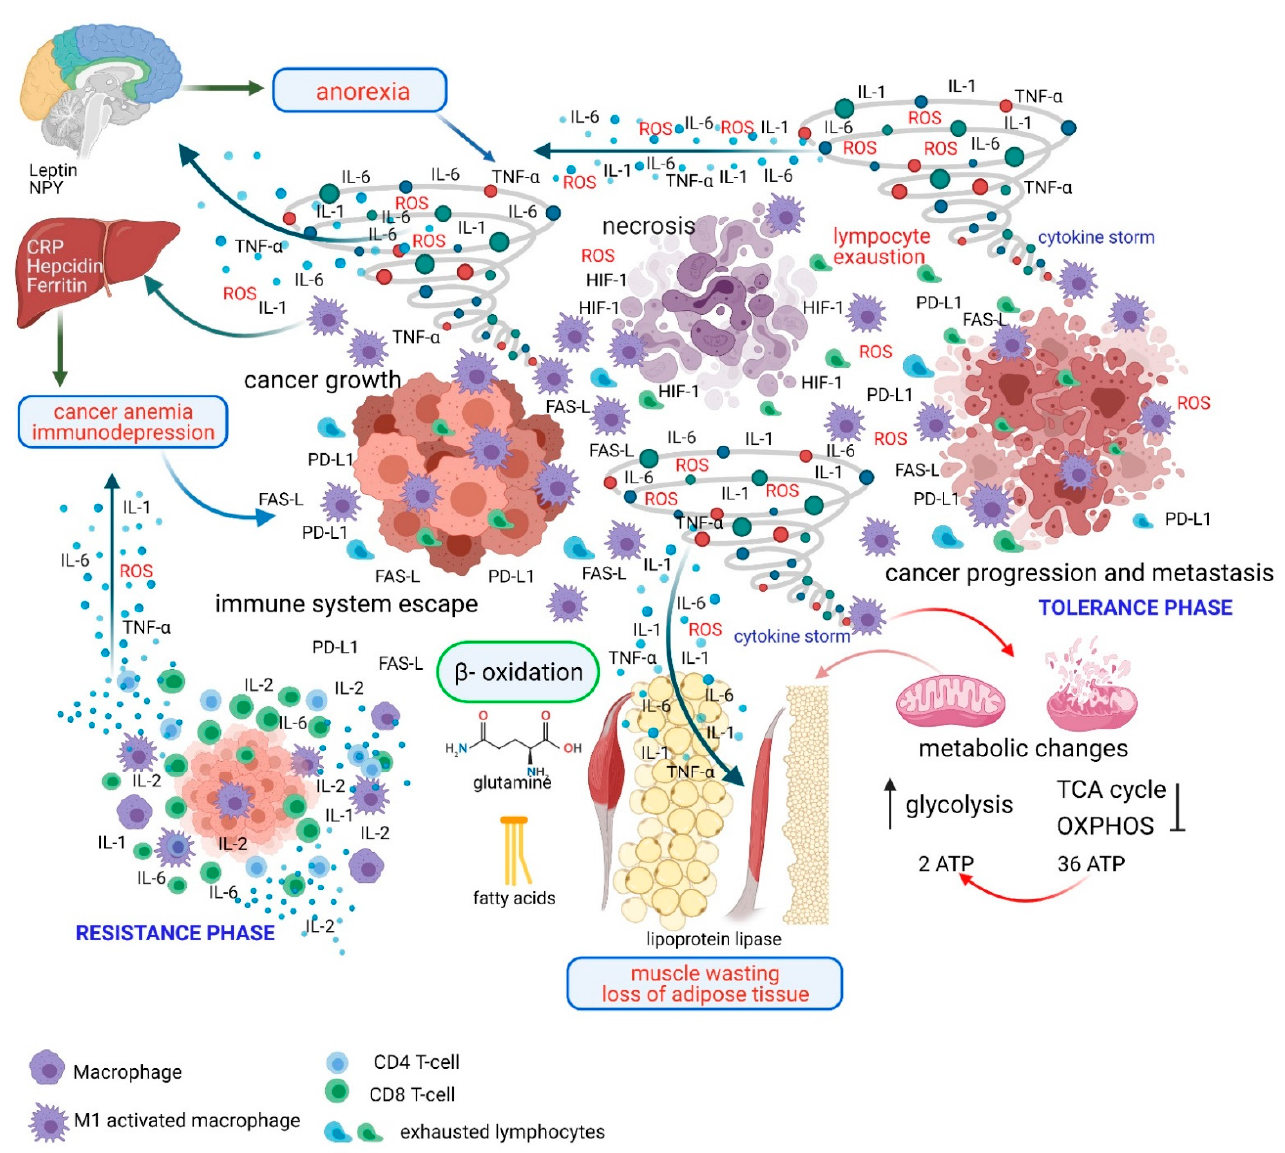
Figure 1. Mechanism of resistance and tolerance and pathogenesis of cachexia during the evolution of cancer. In the resistance phase the immune system recognize the antigenic diversity of the tumor and tries to eliminate it. Macrophages, dendritic cells and T and B cells are the main participants. In this phase the presence of cancer cells and the activation of the immune system with the release of proinflammatory cytokines (IL-6, IL-1, TNF- α ), HIF-1, and ROS determine specific changes in energy metabolism (increased glycolysis and impaired TCA cycle and OXPHOS) that promote uncontrolled tumor growth. The tumor growth overcoming the resistance phase underlines the lack of efficacy of the specific immune response (lymphocyte exhaustion) followed by the mac-rophage-mediated inflammatory response (cytokine storm) whose persistence leads to the phenomena of tolerance and related symptoms (anorexia, anemia, muscle wasting, loss of adipose tissue). Cachexia as an expression of tolerance aims to minimize the damages induced both by the cancer-growth and by immunopathology. Abbreviations: NPY, Neuropeptide Y; CRP, C-reactive Protein; IL, Interleukin; TNF, Tumor Necrosis Factor; PD-L1, Programmed death-ligand 1; ROS, reactive oxygen species; HIF, hypoxia-inducible factor; FAS-L, Fas ligand; TCA, tricarboxylic acid; OXPHOS, Oxidative phosphorylation; ATP, Adenosine Triphosphate. Figure created with BioRender.com (accessed on 12 March 2021).